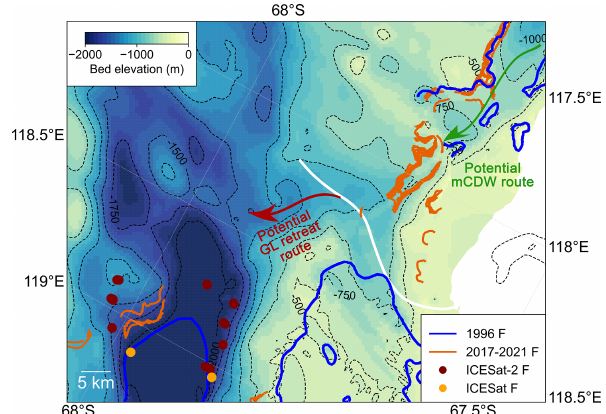
Figure 14. The potential grounding line retreat route at the Moscow University Western Ice Shelf (MUWIS) along the retrograde bed slope is marked by the red arrow into the main glacier trunk of Moscow University Ice Shelf (MUIS). The potential warm modi- fied Circumpolar Deep Water (mCDW) route from Totten Glacier Eastern Ice Shelf (TGEIS) is marked by the green arrow. All map features are overlaid on the BedMachine bed elevation (Morlighem et al.,